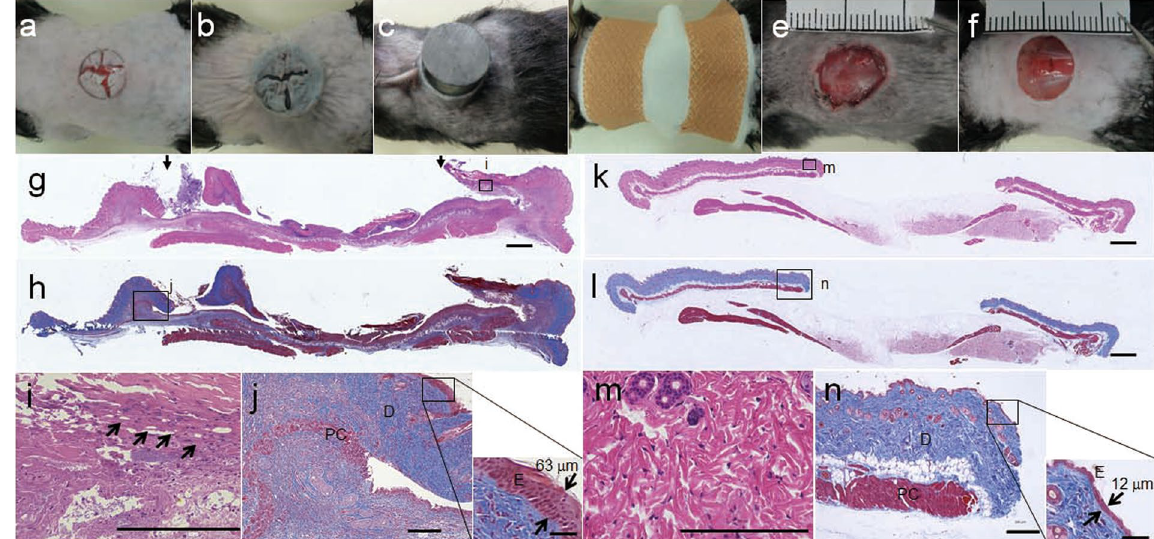
Figure 1. Magnet-implanted ulcer model. ( a – e ) Methods used to prepare magnet-implanted ulcer and ( f ) simple skin defect models. ( g , h ) Representative histologies of ulcers 7 days after magnet implantation. ( g ) Hematoxylin & Eosin (H&E) staining, scale bar = 1000 µ m, and ( h ) Masson trichrome staining, scale bar = 1000 µ m. Two arrows in ( g ) show the edges of ulcer. ( i ) The enlarged image enclosed in a square in ( g ) indicated by the letter “i,” scale bar = 200 µ m. The black arrows show coagulation necroses. ( j ) The magnified image of the area enclosed in the square in ( h ) indicated by the letter “j,” scale bar = 200 µ m. (E, epidermis; D, dermis; PC, panniculus carnosus layer). ( k ) ( l ) Representative histology of the simple skin defect. ( k ) Hematoxylin & Eosin (H&E) staining, scale bar = 1000 µ m and ( l ) Masson trichrom staining, scale bar = 1000 µ m. ( m ) The enlarged image enclosed in the square in ( k ) indicated by the letter “m,” scale bar = 200 µ m. ( n ) The image enclosed in the square in ( l ) indicated by the letter “n,” scale bar = 200 µ m. (E: epidermis; D, dermis; PC, panniculus carnosus